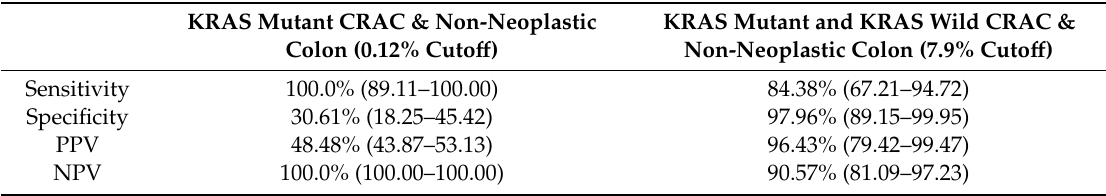
Table 1. Diagnostic value of KRAS G12/13 mutation by ddPCR depending on mutant cutoff criteria. KRAS Mutant CRAC & Non-Neoplastic KRAS Mutant and KRAS Wild CRAC Colon (0.12% Cuto ff )